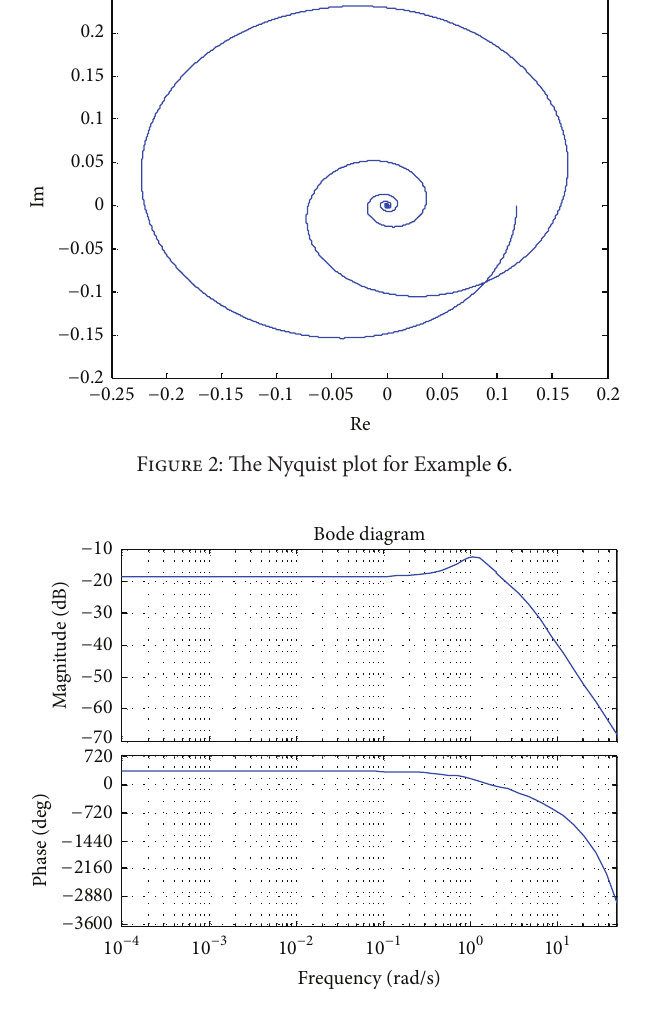
Figure 3: The Bode diagram for Example 6.